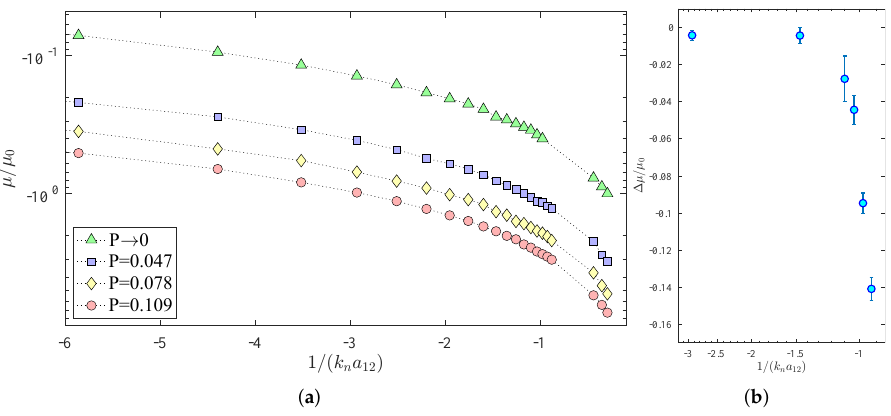
Figure 2. ( a ) EoS for polarons (ground-state) we added a and b for subfigure, please check. as a function of the number of impurities and coupling strength. Error bars are smaller than the size symbol. ( b ) Induced interaction for a ultra dilute gas of impurities computed as in Equation (20) for a polarization P =